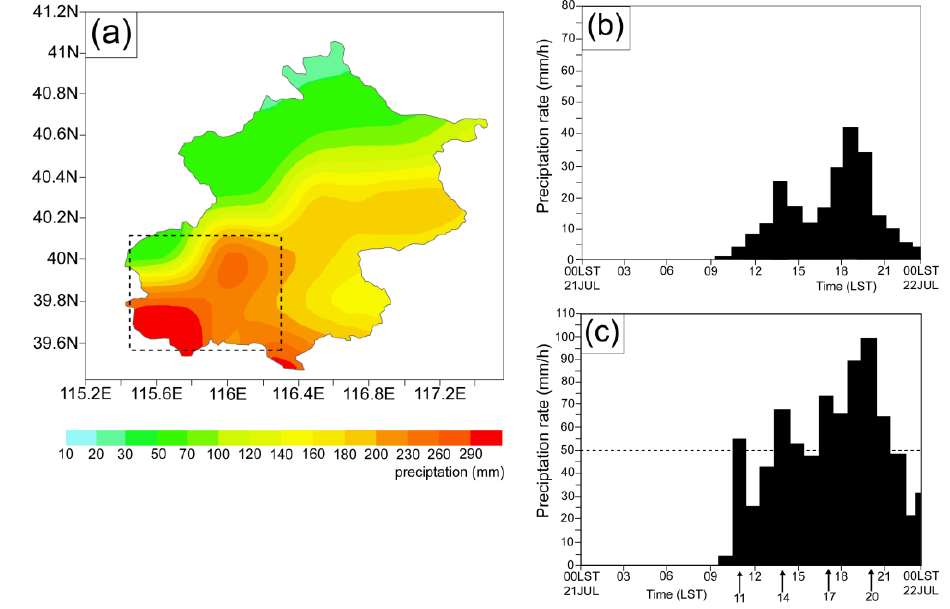
Figure 6. Observed precipitation over Beijing on 21 July 2012. ( a ) the horizontal distribution of the total rainfall during 08:00 LST 21 July–08:00 LST 22 July 2012 (unit: mm); ( b ) time evolution of the area-averaged rainfall within the black dash rectangle area in Figure 6a; ( c ) same as Figure 6b but for the time evolution of the maximum rainfall observed in the dash rectangle area in Figure 6a (Unit: mm). According to the synoptic features, the rainstorm was occurred accompanied with a synoptic frontal cyclone (not shown). Meanwhile, two tropical storms “Vicente” and “Khanun” generated in the northwest Pacific supplied plenty moisture (over 9×10 −3 g ∙ cm −1 ∙ h ∙ Pa −1 ∙ s −1 [22]) to the precipitation